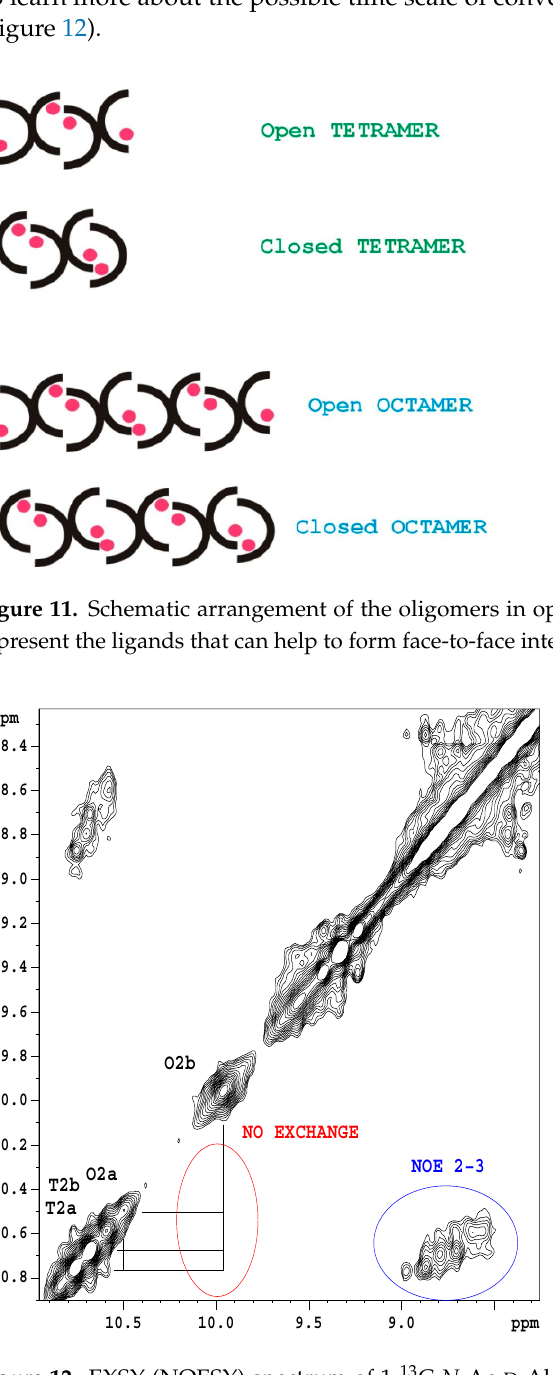
Figure 12. EXSY (NOESY) spectrum of 1- 13 C N -Ac- D -Ala- D -Ala-saturated eremomycin at 278 K, mixing time 100 ms. The w2 amide group signals belonging to tetramer (T2a, T2b) and octamer (O2a, O2b) are separated on the diagonal, but no off-diagonal exchange peaks are visible between tetramer and octamer states. However, the intramolecular NOESY peaks are observable.